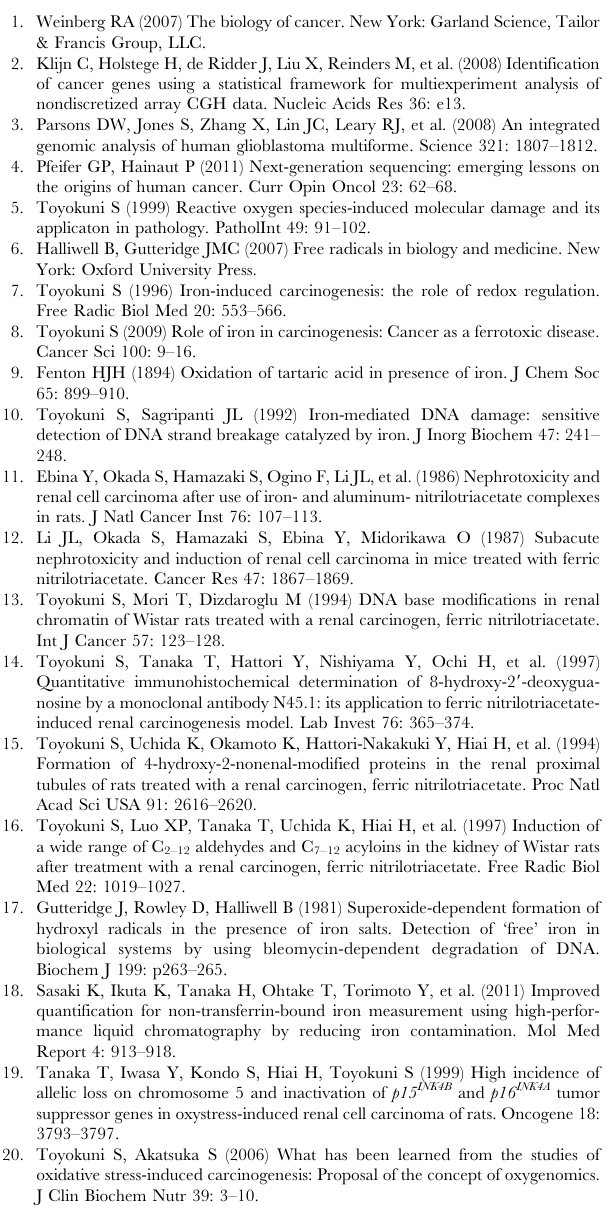
Figure S4 Zbtb38 mRNA expression is demonstrably associated with its chromosomal copy number. (A) Array- CGH profiles of two RCC tumors harboring amplification over Zbtb38 locus on chromosome 8. (B) Expression analysis of Zbtb38 on 13 RCC tumors by real-time PCR. The values of the y -axis indicate the relative mRNA expression level compared to an average of those in normal kidneys of three control rats. Figure S5 Array-CGH profiles of three hereditary (Eker rat) renal tumors. Red lines show log2 ratios of estimated copy number over inferred cancer ploidy versus genomic position for all the CGH microarray probes. Table S1 List of genes completely deleted in more than two RCC tumors.